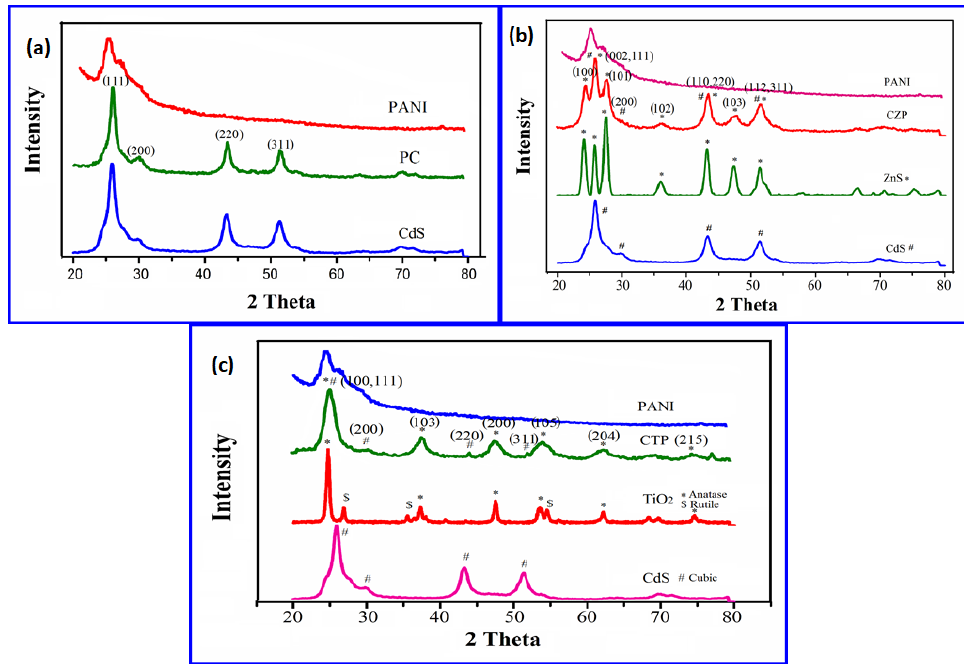
Figure 6. ( a ) XRD pattern of PC in comparison to cubic CdS and synthesized PANI ( b ) XRD pattern of CZP in comparison to cubic CdS, hexagonal ZnS and PANI ( c ) XRD pattern of CTP in comparison to cubic CdS, Degussa P-25 TiO 2 and PANI.